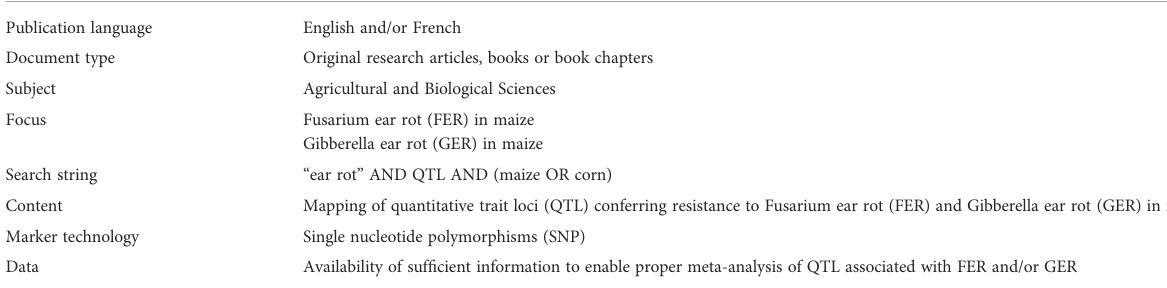
TABLE 1 Inclusion and exclusion